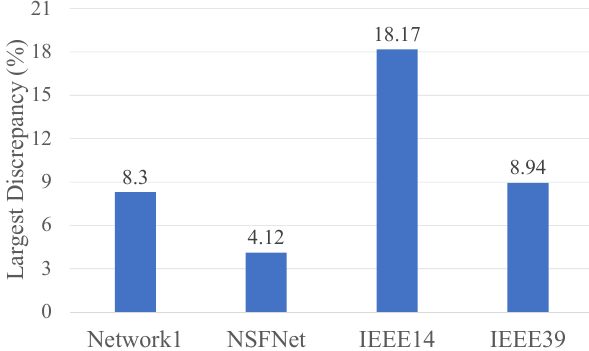
Figure 15. Summary of the largest additional costs required by GRASP for the different considered distribution